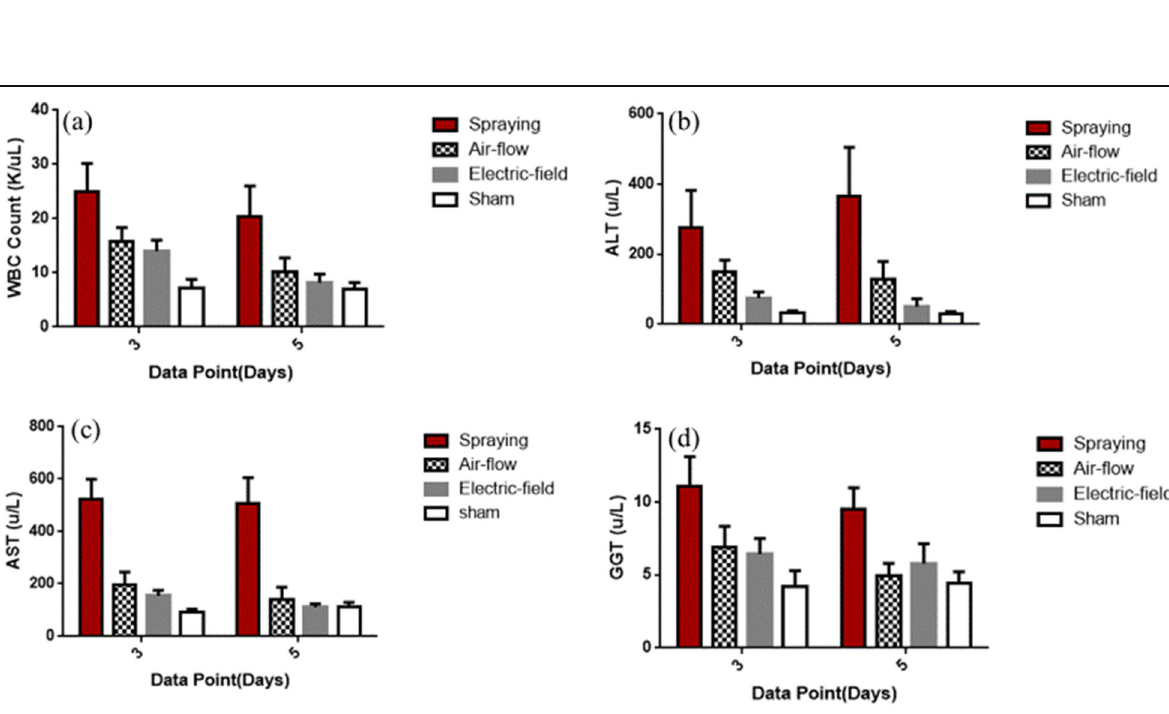
Fig. 5 Blood test. a WBC count. b – d Liver function enzyme test. b Alanine aminotransferase (ALT). c Aspartate aminotransferase (AST). d Glutamyltransaminase (GGT)